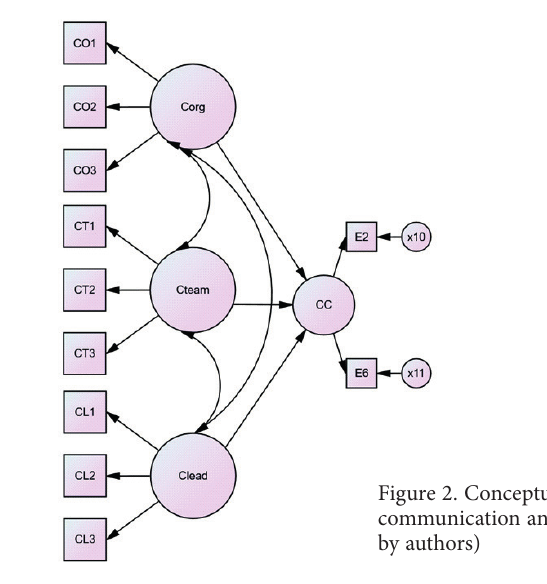
Figure 2. Conceptual model of organizational communication and creativity (source: created by